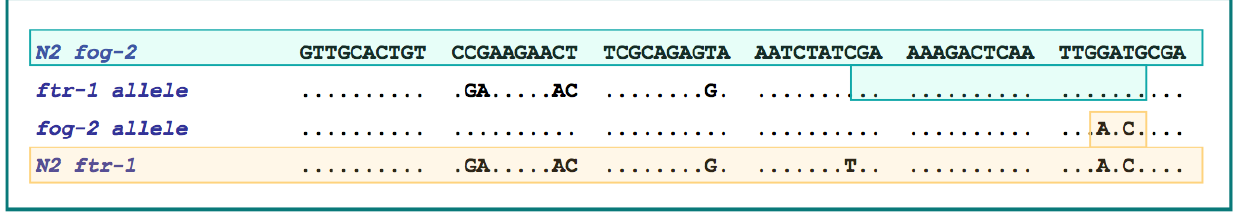
Figure 4. Evidence of gene conversion in both fog-2 and ftr-1 alleles in natural isolates of C. elegans [47]. The top and bottom sequences (highlighted in green and yellow throughout, respectively) represent base positions 470-589 of the fog-2 and ftr-1 alleles of the N2 laboratory strain. Dots represent nucleotides identical to the N2 fog-2 sequence. The second sequence labeled „ ftr-1 allele‟ represents a gene conversion event in ftr-1 by a fog-2 donor sequence. The minimum gene conversion tract length of 9 bp in this converted ftr-1 allele is highlighted in green to display its sequence identity to the N2 fog-2 allele. The region surrounding this converted tract has 100% sequence identity between N2 fog-2 and ftr-1 alleles over a 102 bp stretch, which would represent the maximum length of the gene conversion tract. This converted ftr-1 allele was detected in 20 of the 40 natural isolates surveyed. The third sequence labeled „ fog-2 allele‟ represents a gene conversion event in fog-2 by an ftr-1 donor sequence possessed by three of 40 natural isolates. The minimum gene conversion tract length of 3 bp in this converted fog-2 allele is highlighted in yellow to display its sequence identity to the N2 ftr-1 allele. The region surrounding the converted nucleotides is identical between fog-2 and ftr-1 over a span of 93 bp, representing